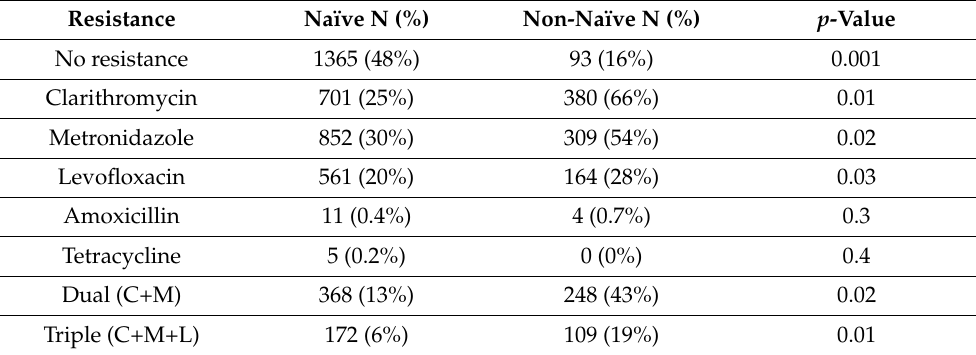
Table 4. Helicobacter pylori resistance against different antibiotics tested in naïve and non-naïve